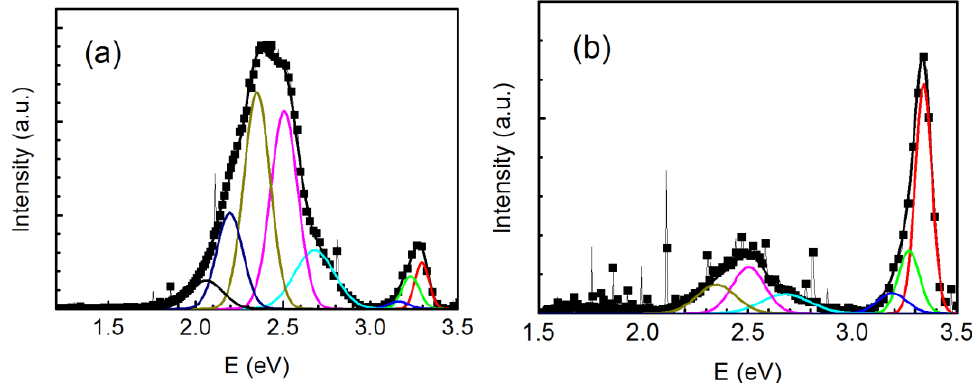
Figure 3. The photoluminescence spectrum for ( a ) ZnO and ( b ) MgZnO at room